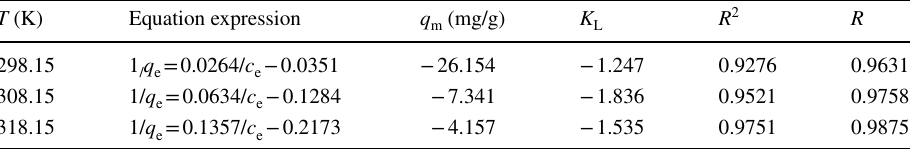
Table 3 Langmuir isothermal equation and